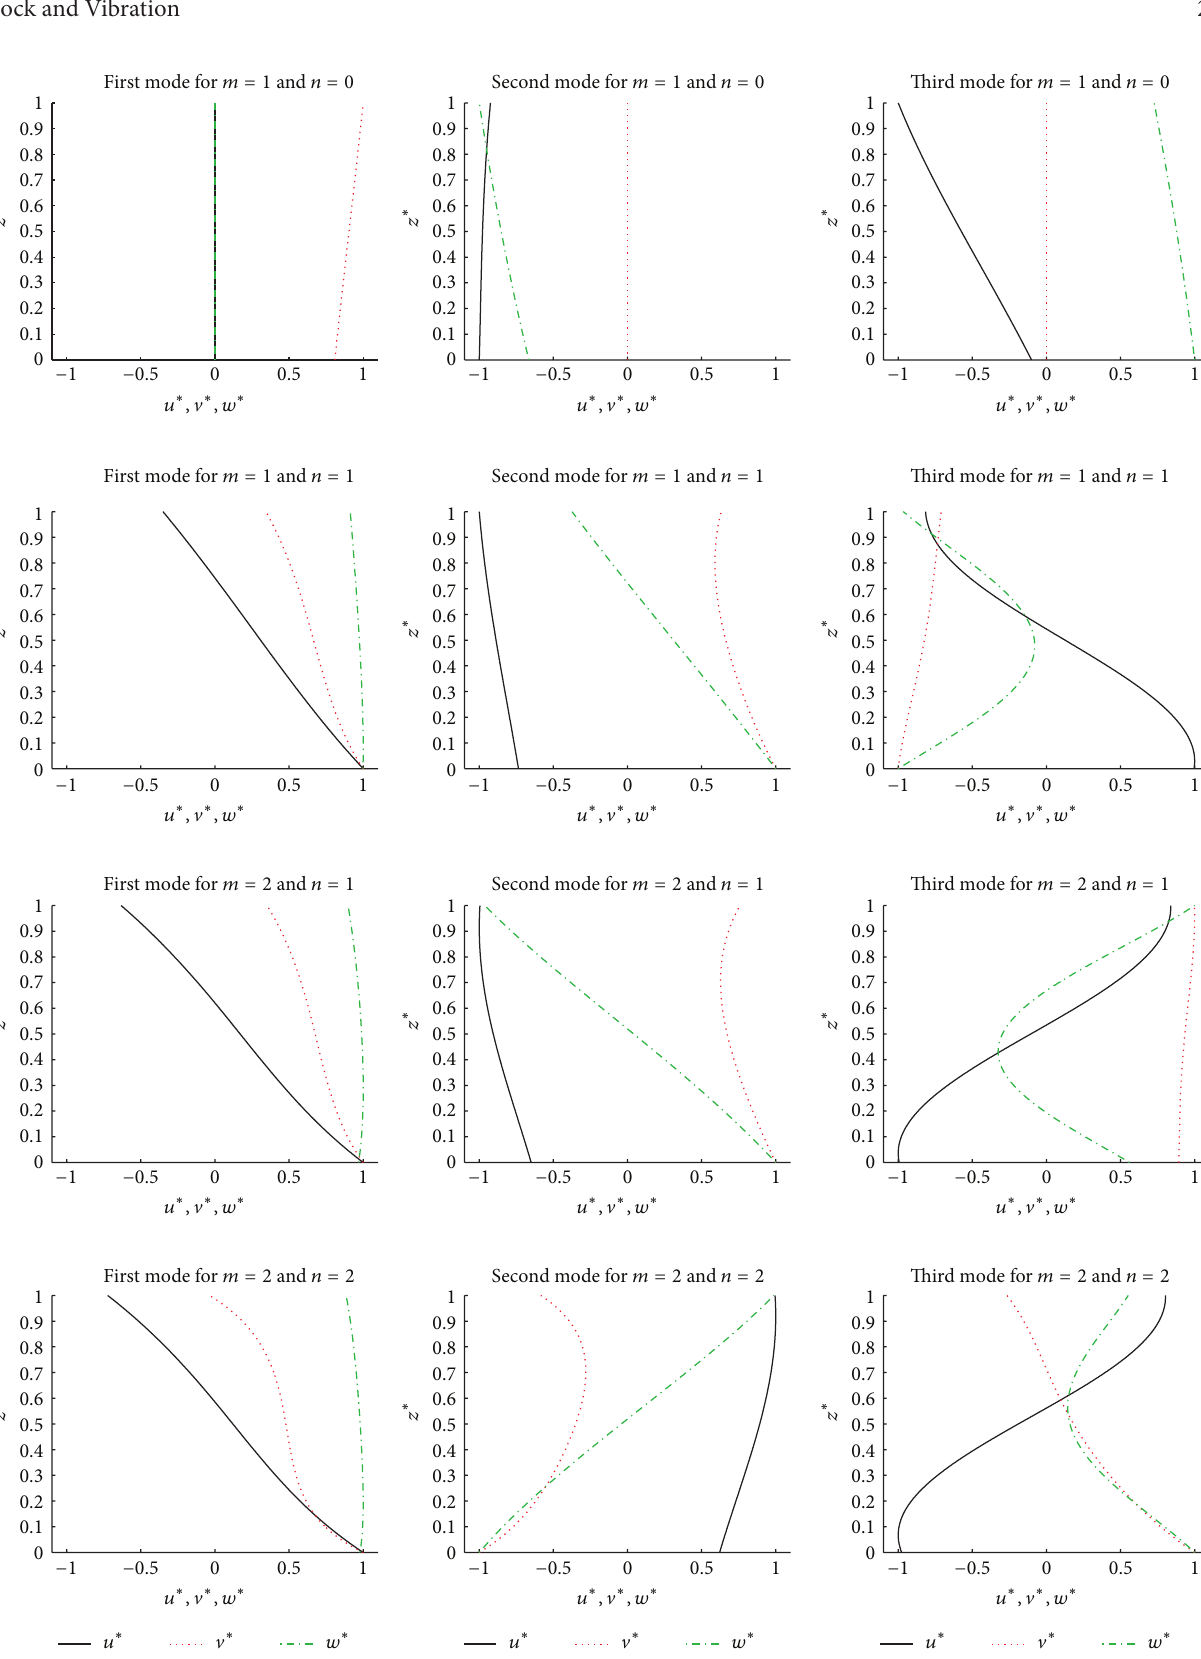
Figure 12: Benchmark 10, simply supported orthotropic spherical shell panel (𝜃 = 90 ∘ ). First three vibration modes in terms of displacement components through the thickness for thickness ratio 𝑅 𝛼 /ℎ = 5 and several combinations of half-wave